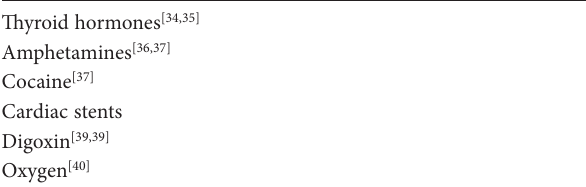
Table 1. Drugs and devices increasing entropy